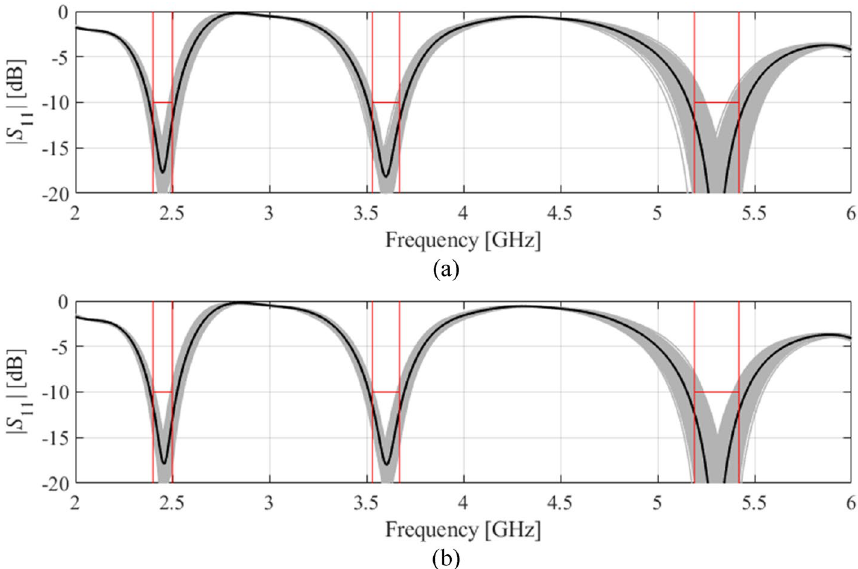
Figure 6. Visualization of EM-driven Monte Carlo simulation of Antenna III using 500 samples. Gray plots represent random observables, whereas the black plot is the antenna response at the center design (nominal for ( a ) and yield-optimized for ( b )). Target operating bandwidths and reflection level has been marked using vertical and horizonal lines, respectively: ( a ) nominal design, ( b ) robust design.